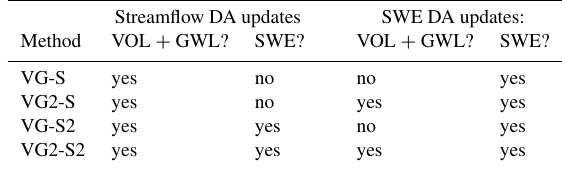
Table 1. Overview of multivariate DA scenarios.